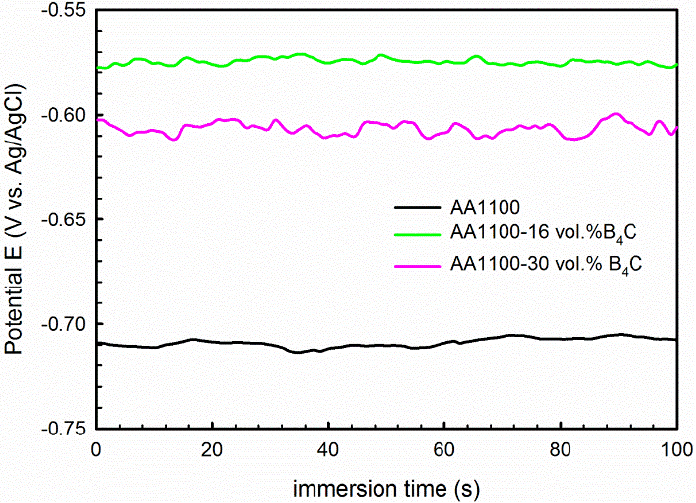
Figure 4. E as a function of time measured 100 seconds before EIS tests, showing the E Figure 4. E ocp as a function of time measured 100 seconds before EIS tests, showing the E ocp ocp ocp of AA1100, AA1100-16 vol.% B C and AA1100-30 vol.% B C is stable before EIS of AA1100, AA1100-16 vol.% B 4 C and AA1100-30 vol.% B 4 C is stable before EIS tests. 4 4